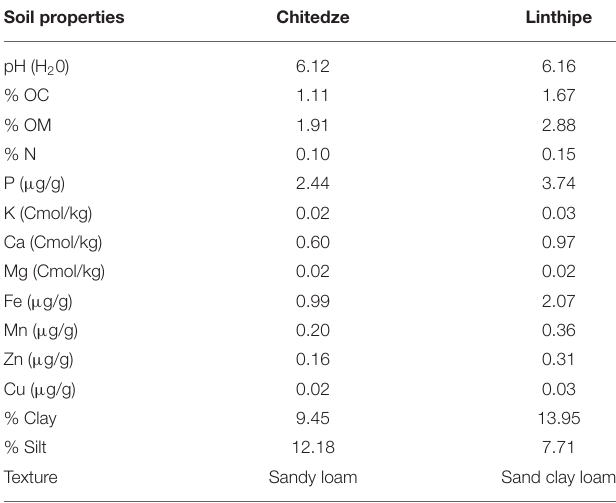
TABLE 1 | Mean monthly rainfall (mm) at Chitedze and Linthipe in 2018/2019 and 2019/2020 cropping seasons. Months Chitedze